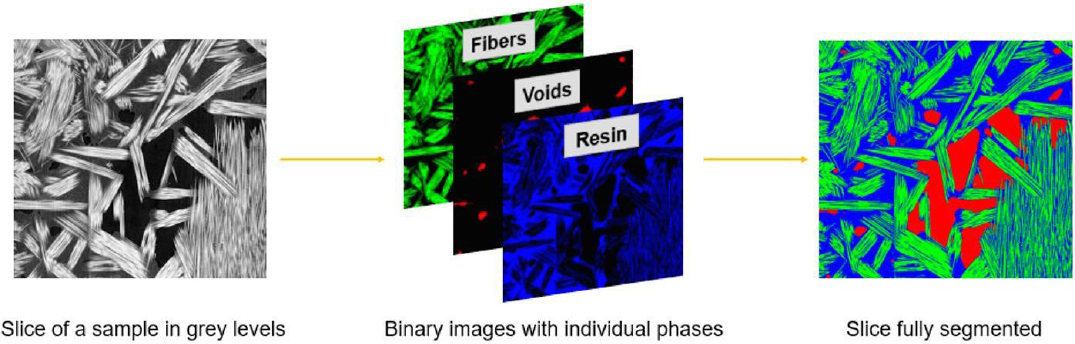
Figure 6. Segmentation workflow of fiber, voids and resin. Table 3. Parameters used for the creation of the Gabor filter bank.